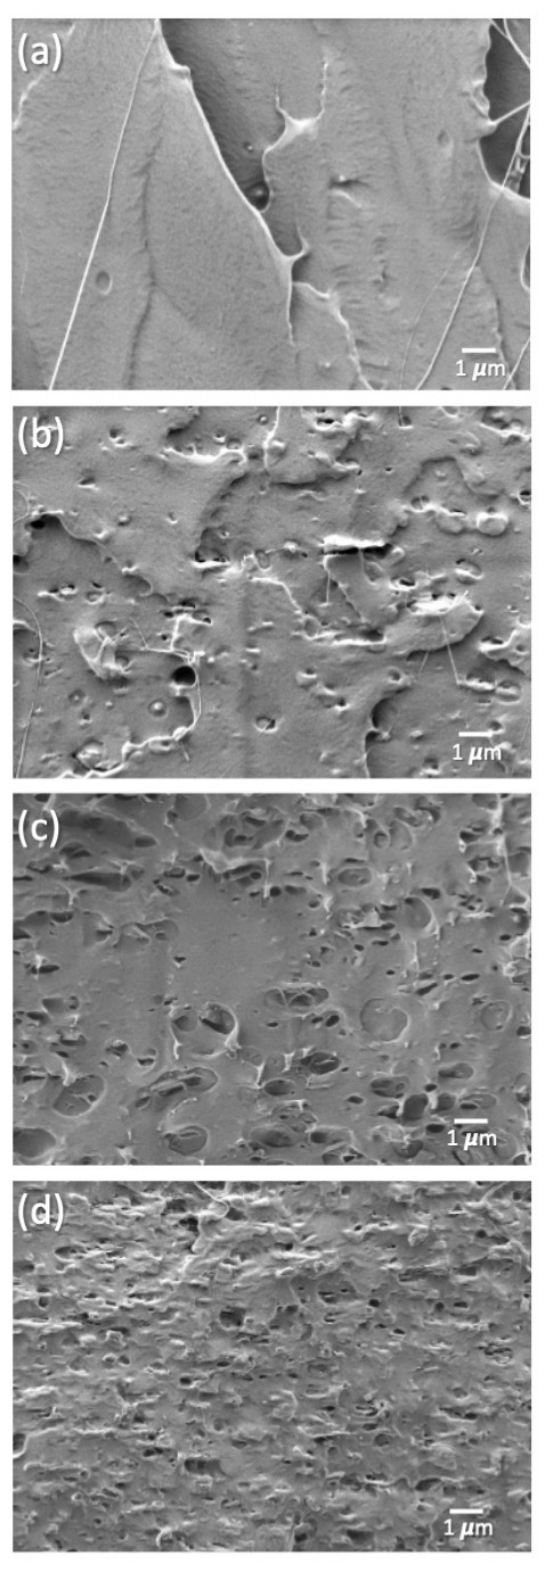
Figure 3. SEM micrographs of cross-section of freeze-fractured samples at 5.0 kx of PLA film sam- ples. ( a ) PLA neat nanocomposites, ( b ) PLA 1% C30B, ( c ) PLA 2% C30B, and ( d ) PLA 3%C30B.